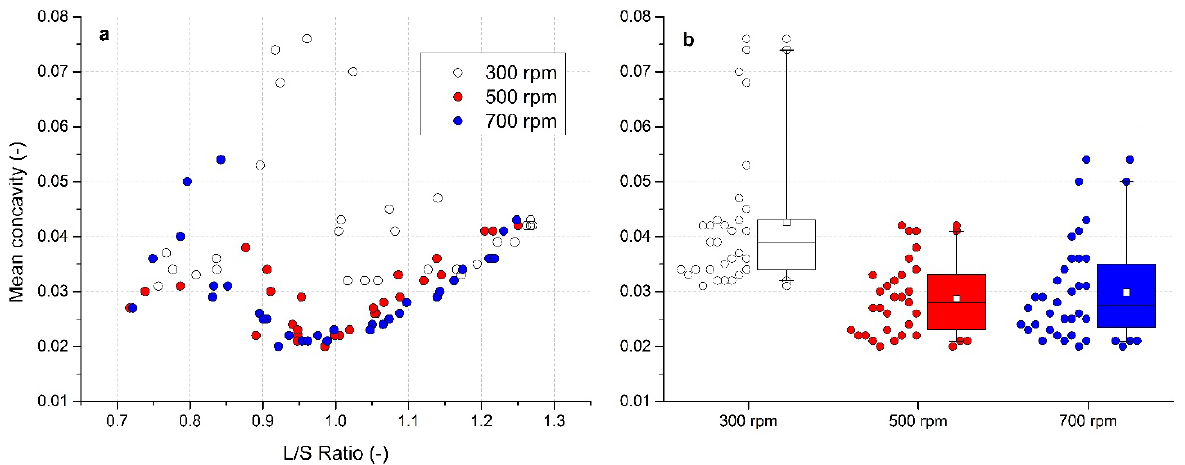
Figure 9. Evaluation of mean concavity for impeller speeds 300, 500, and 700 rpm: ( a ) effect of the L/S ratio on mean concavity, ( b ) box charts of mean concavity for different impeller speeds.